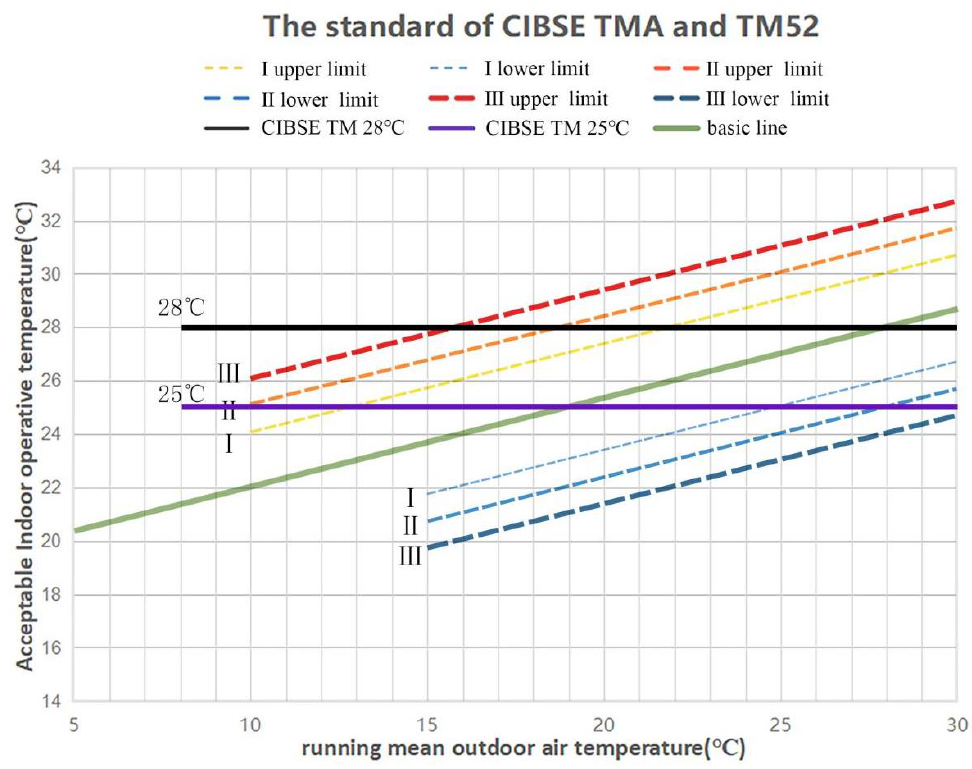
Figure 2. The standard of CIBSE TMA and TM52.